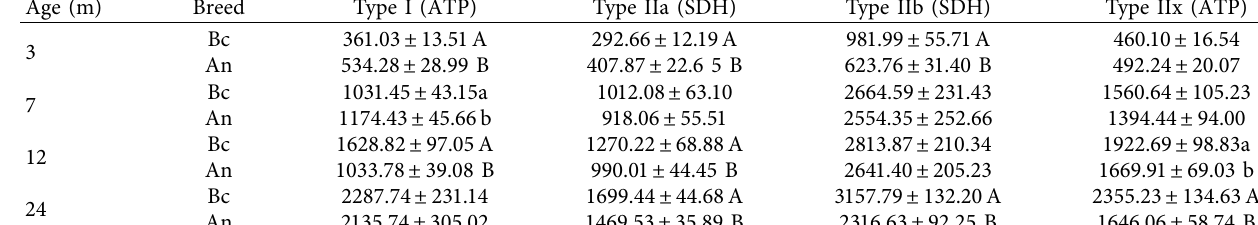
Table 4: Comparison of CSA of different types of muscle fibers between the same month of Xinjiang brown cattle and Angus cattle in the longissimus dorsi muscle ( μ m 2 ).